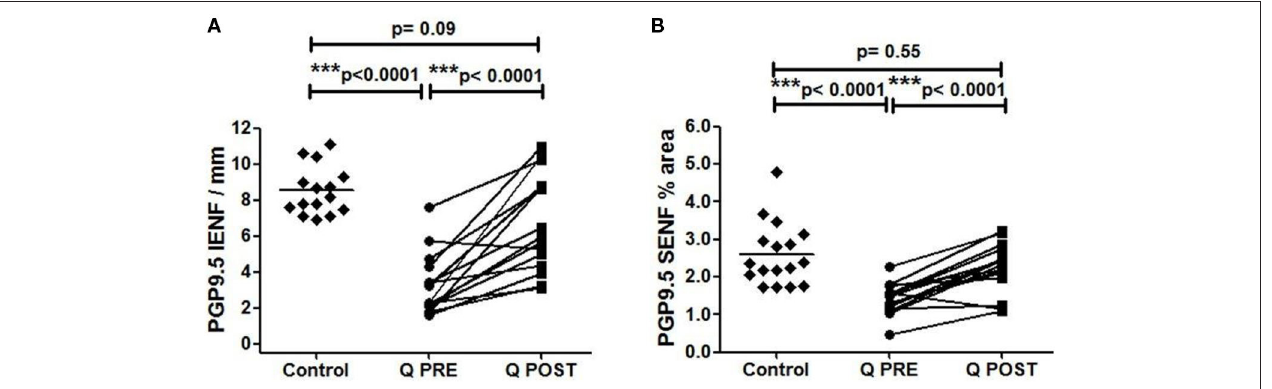
FIGURE 2 | Immunohistochemistry results in skin biopsies for PGP9.5-positive nerve fibres. (A) Intra-epidermal PGP9.5 nerve fibres (IENFs/mm) at baseline (Q PRE), and significant increase at 3 months after treatment (Q POST) with Capsaicin 8% patch Qutenza (Q) (paired t -test). Statistically significant difference between control group and baseline (Q PRE), but not significant after treatment (Q POST) (Mann-Whitney test). (B) Sub-epidermal PGP9.5 nerve fibres (SENFs; % Area) at baseline (Q PRE) and 3 months after treatment (Q POST) with Capsaicin 8% patch Qutenza (Q). Statistically significant increase after Capsaicin 8% patch application (paired t- test). Statistically significant difference between control and treated group before (Q PRE) but not after (Q POST) Capsaicin 8% patch application (Mann-Whitney test).